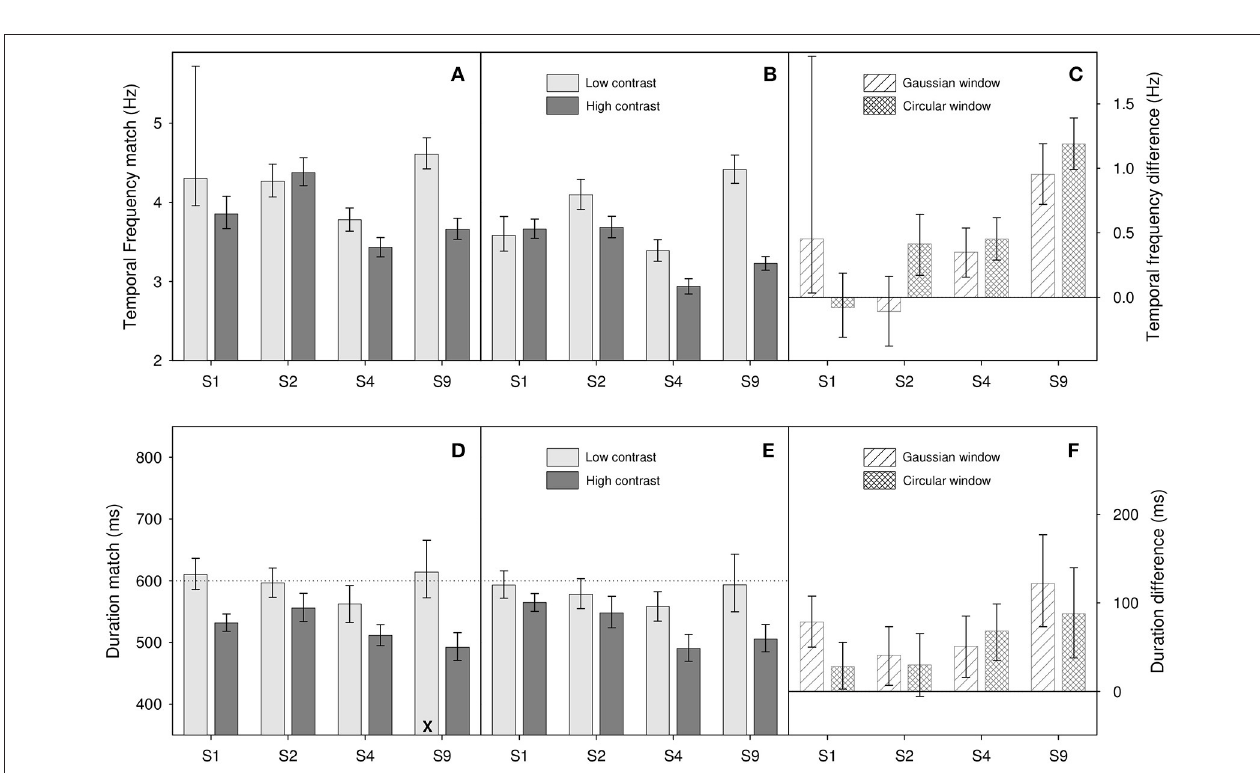
FIGURE 4 | Results from Experiment 2 for (A,D) Gaussian windowed stimuli, (B,E) circular windowed stimuli, (C,F) temporal frequency/duration differences for both. Top panels (A–C) show temporal frequency match results, bottom panels (D–F) show duration match results. Light gray bars show matches for the low contrast (0.1) stimuli, dark gray bars show matches for high contrast (0.9) stimuli. Diagonally hatched bars show temporal frequency/duration differences for Gaussian windowed stimuli, cross-hatched bars show differences for the circular windowed stimuli. Error bars show 95% confidence